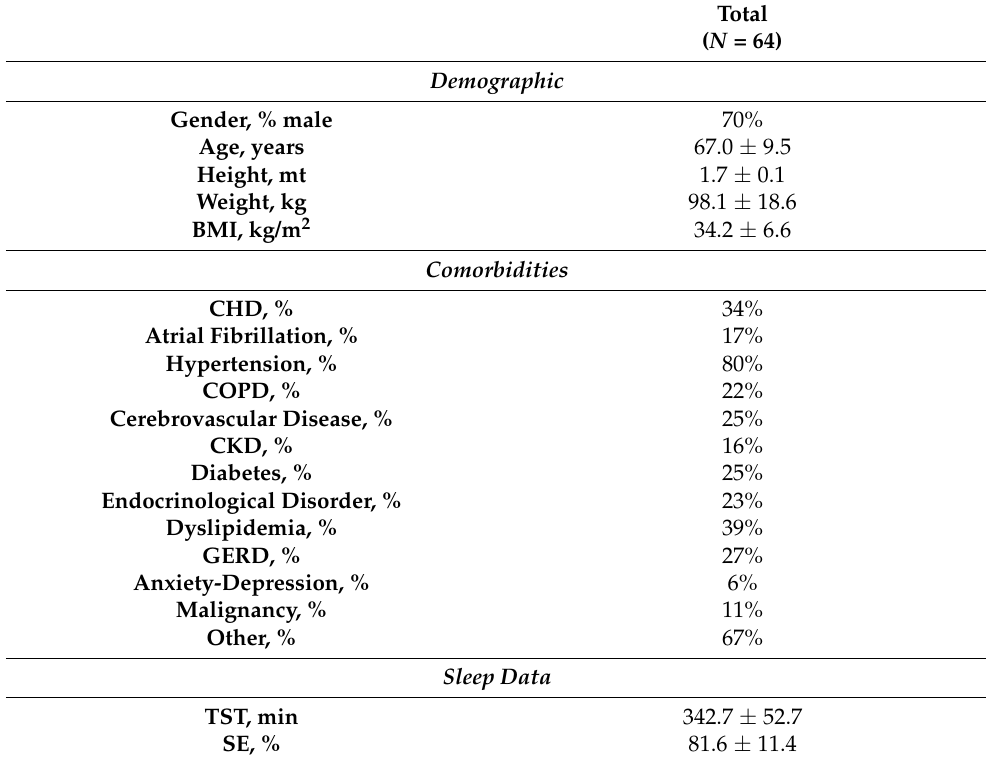
Table 1. Baseline characteristics of population in the